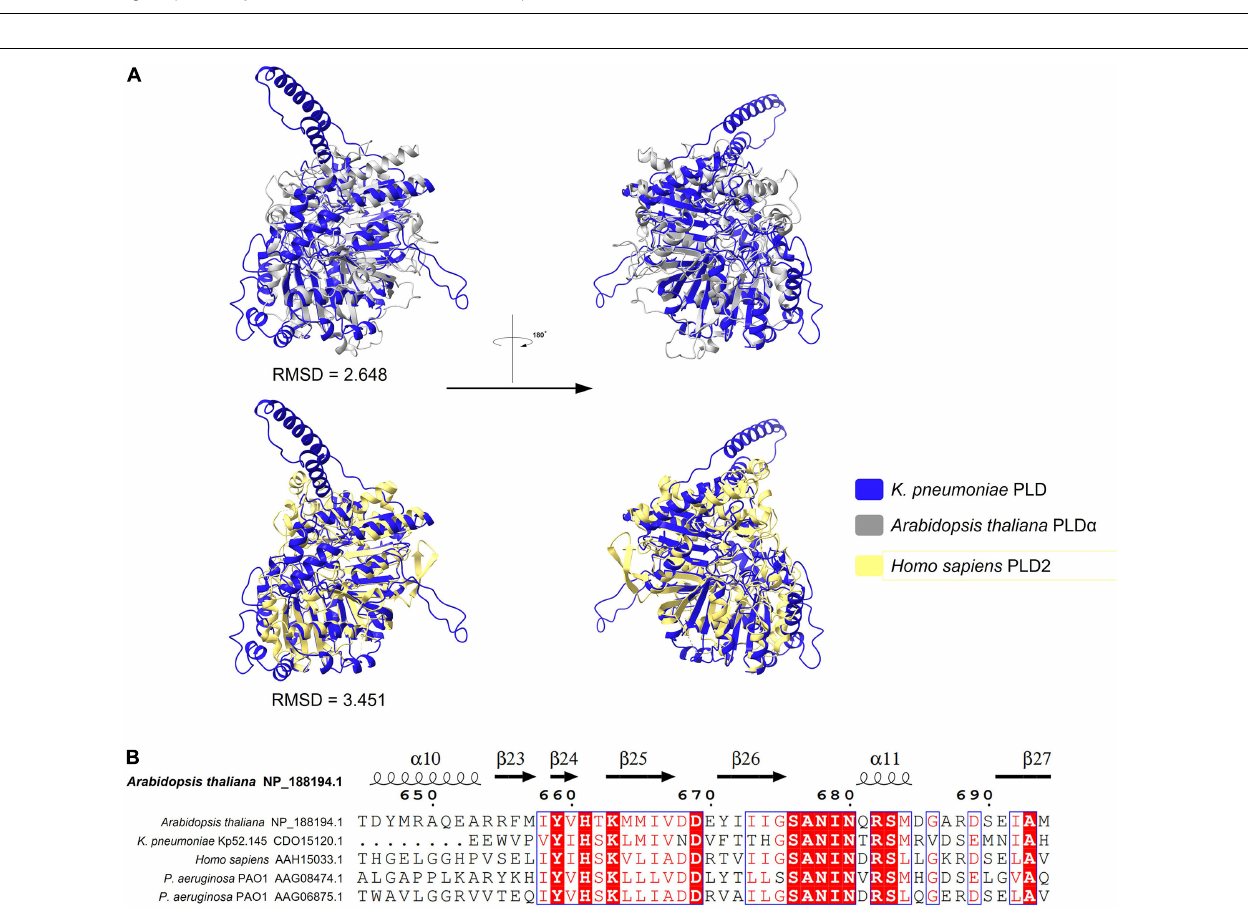
FIGURE 10 | Predicted structure of K. pneumoniae PLD fold with analogous PLD domain. (A) Superimposition structure of K. pneumoniae PLD prediction structure (blue, predicted by AlphaFold2) with Arabidopsis PLD α (silvery, PDB:6KZ9), or human PLD2 catalytic domain structure (yellow, PDB:6OHM). (B) Sequence alignment among PLD proteins showing the HKD motif that are conserved. Refer to Supplementary Files 2 for raw multiple sequence alignment.